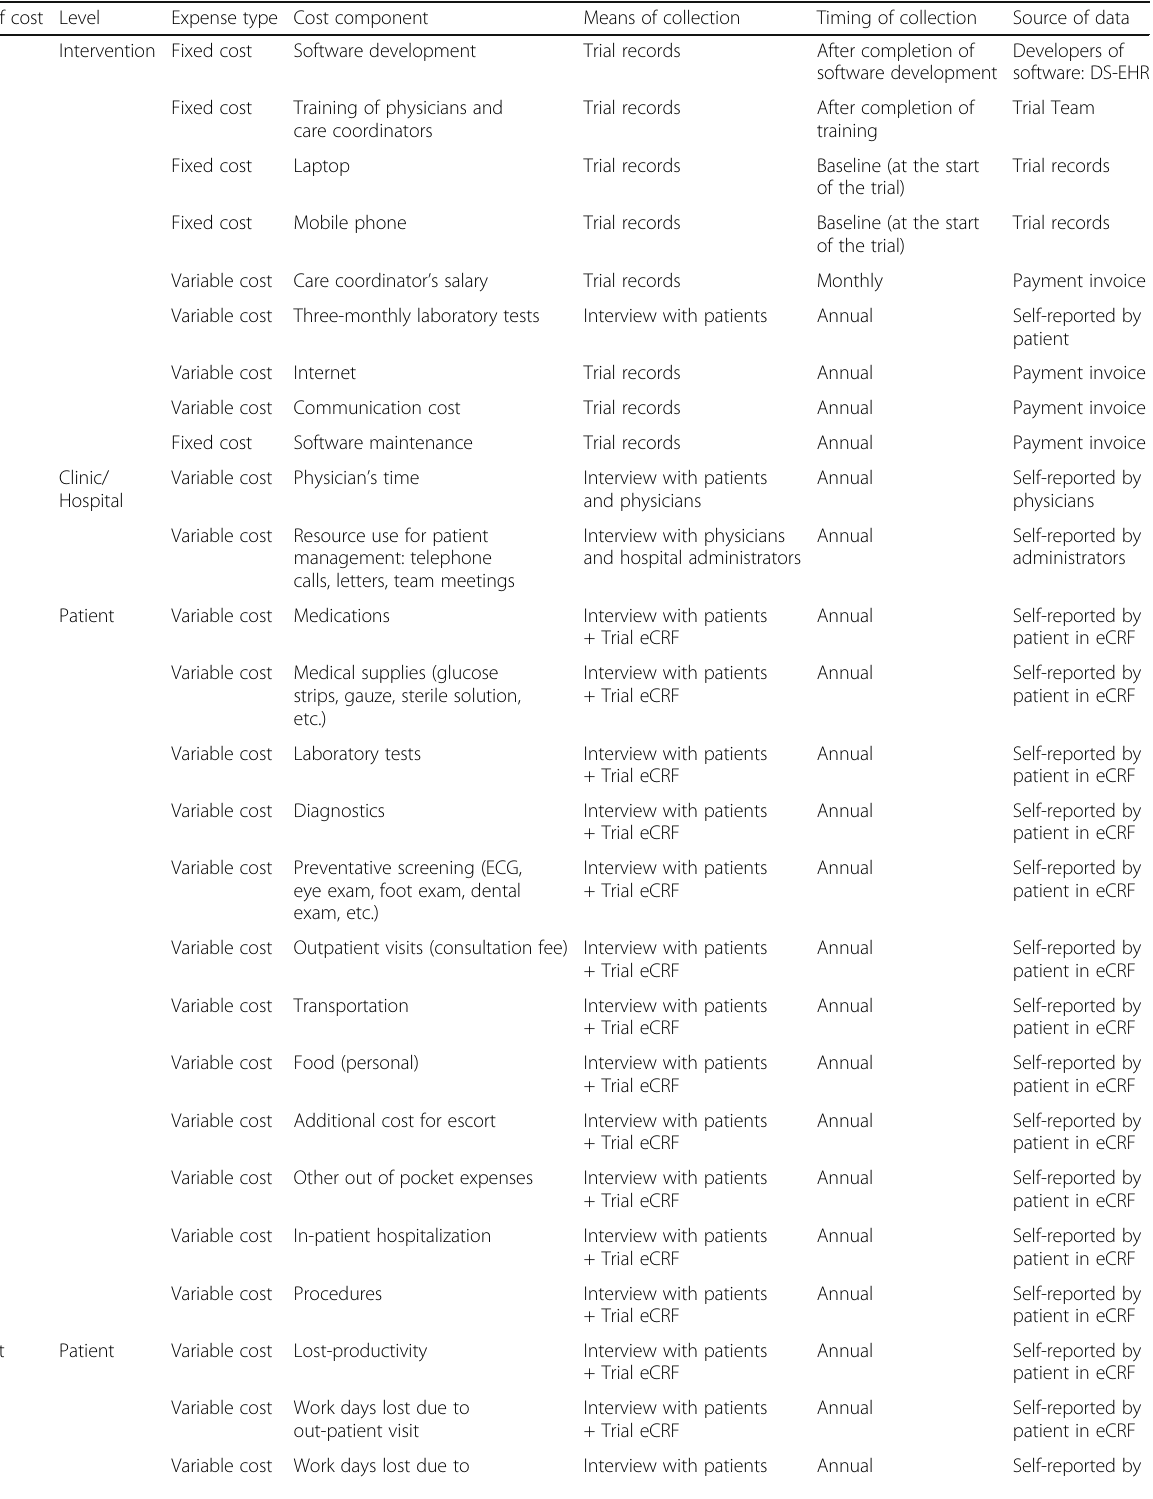
Table 2 Overview of cost measures Type of cost